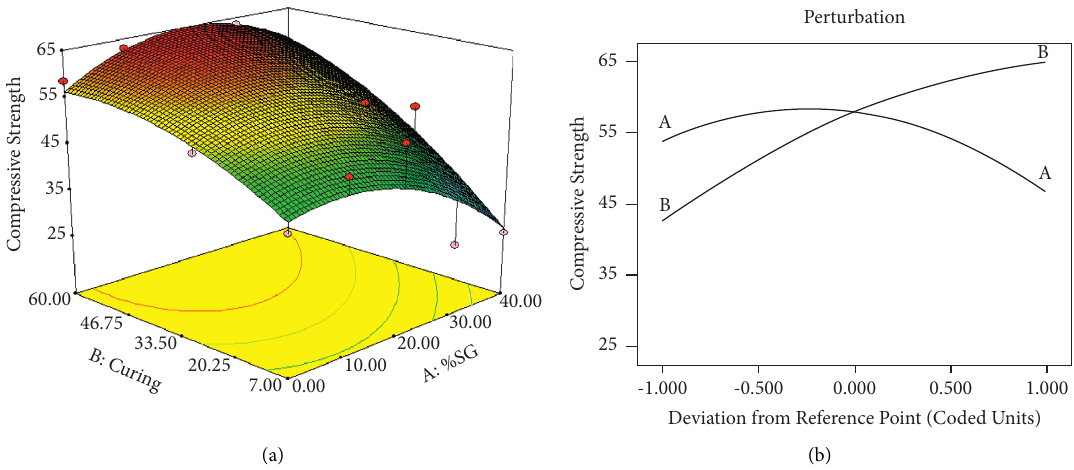
Figure 10: Response surface plots (a) and perturbation plots (b) indicating the relationship between spent garnet content and curing days with respect to compressive strength.